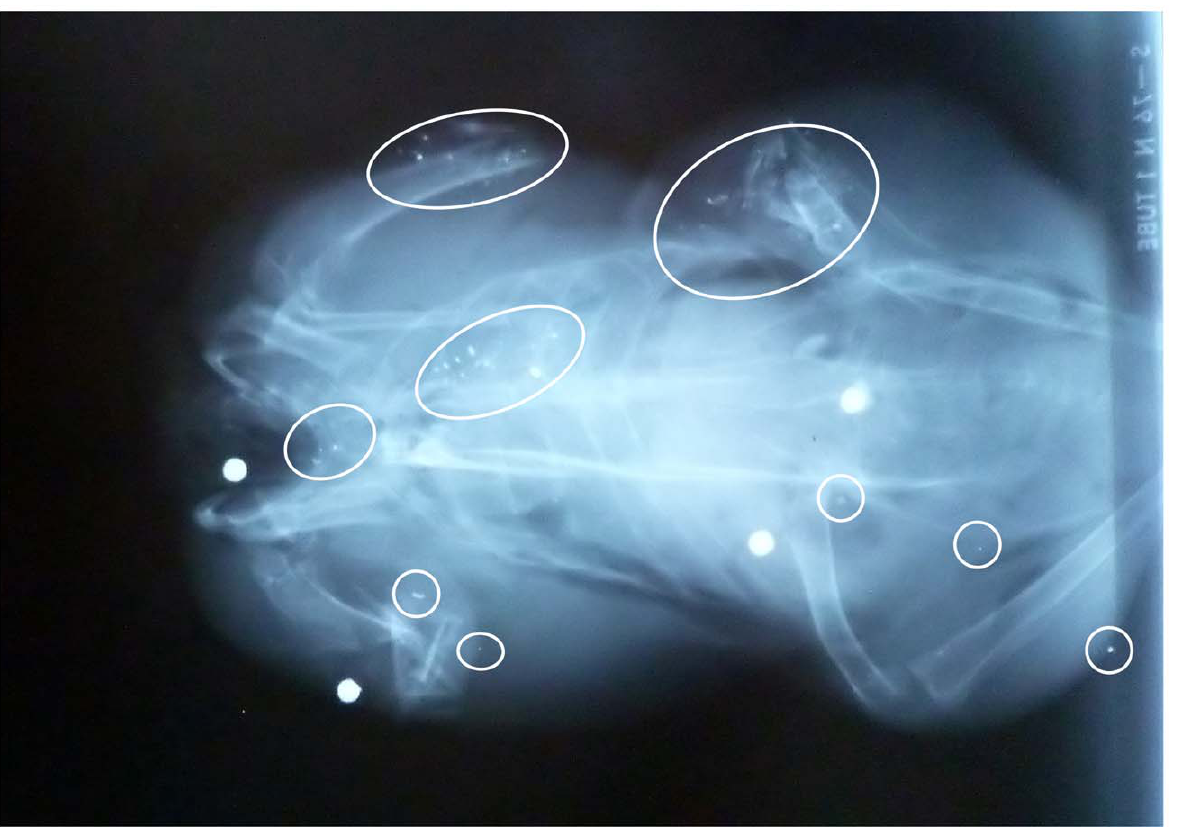
Figure 1. X-ray of a woodpigeon illustrating four gunshot and numerous small radio-dense fragments. Radio-dense fragments may trace the passage of shot through the bird; some fragments are close to bone suggesting fragmentation on impact, others are not.